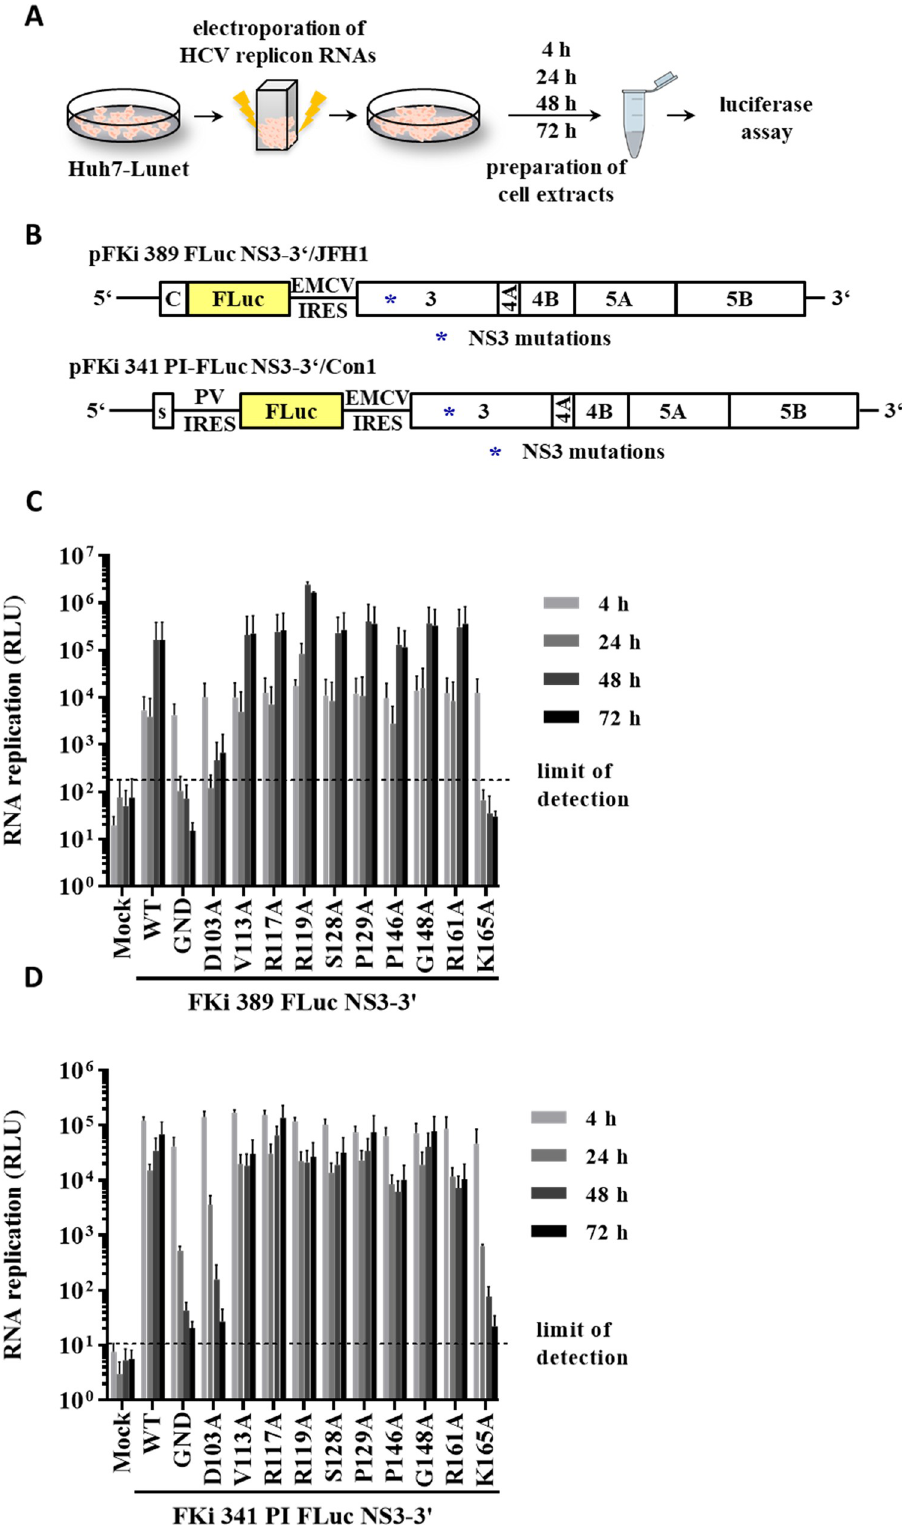
Fig 2. Replication analysis of NS3 protease surface mutations in the JFH1 NS3-3’ replicon identified K165 as critical residue for functional replication complex formation. (A) Workflow to analyze RNA replication ability